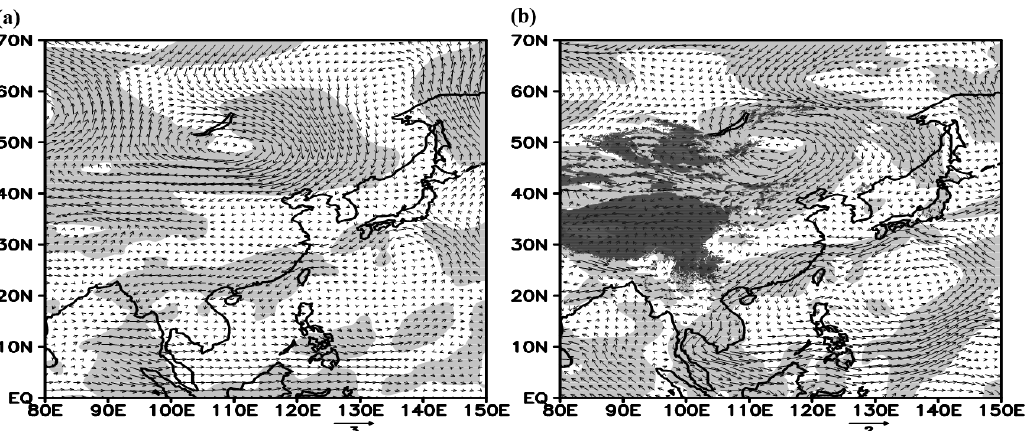
Figure 7. As in Figure 6a, but for anomalous winds (unit: m·s − 1 ) at the 500- ( a ) and 850-hPa ( b ) levels. Shadings denote anomalous winds significant at the 90% confidence level.